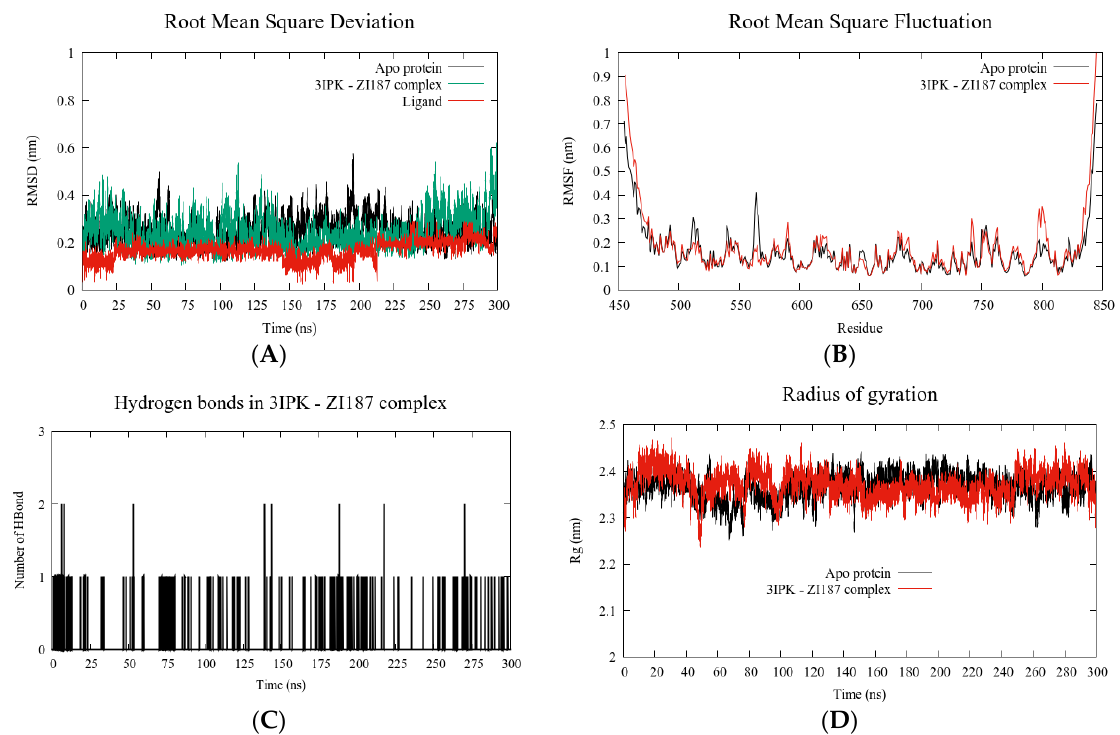
Figure 7. Molecular dynamics simulations analysis. Root Mean Square Deviation (RMSD) ( A ), Root Mean Square Fluctuation (RMSF) ( B ), hydrogen bonds ( C ) and Radius of gyration ( D ) calculated for ZI-187/3IPK complex.